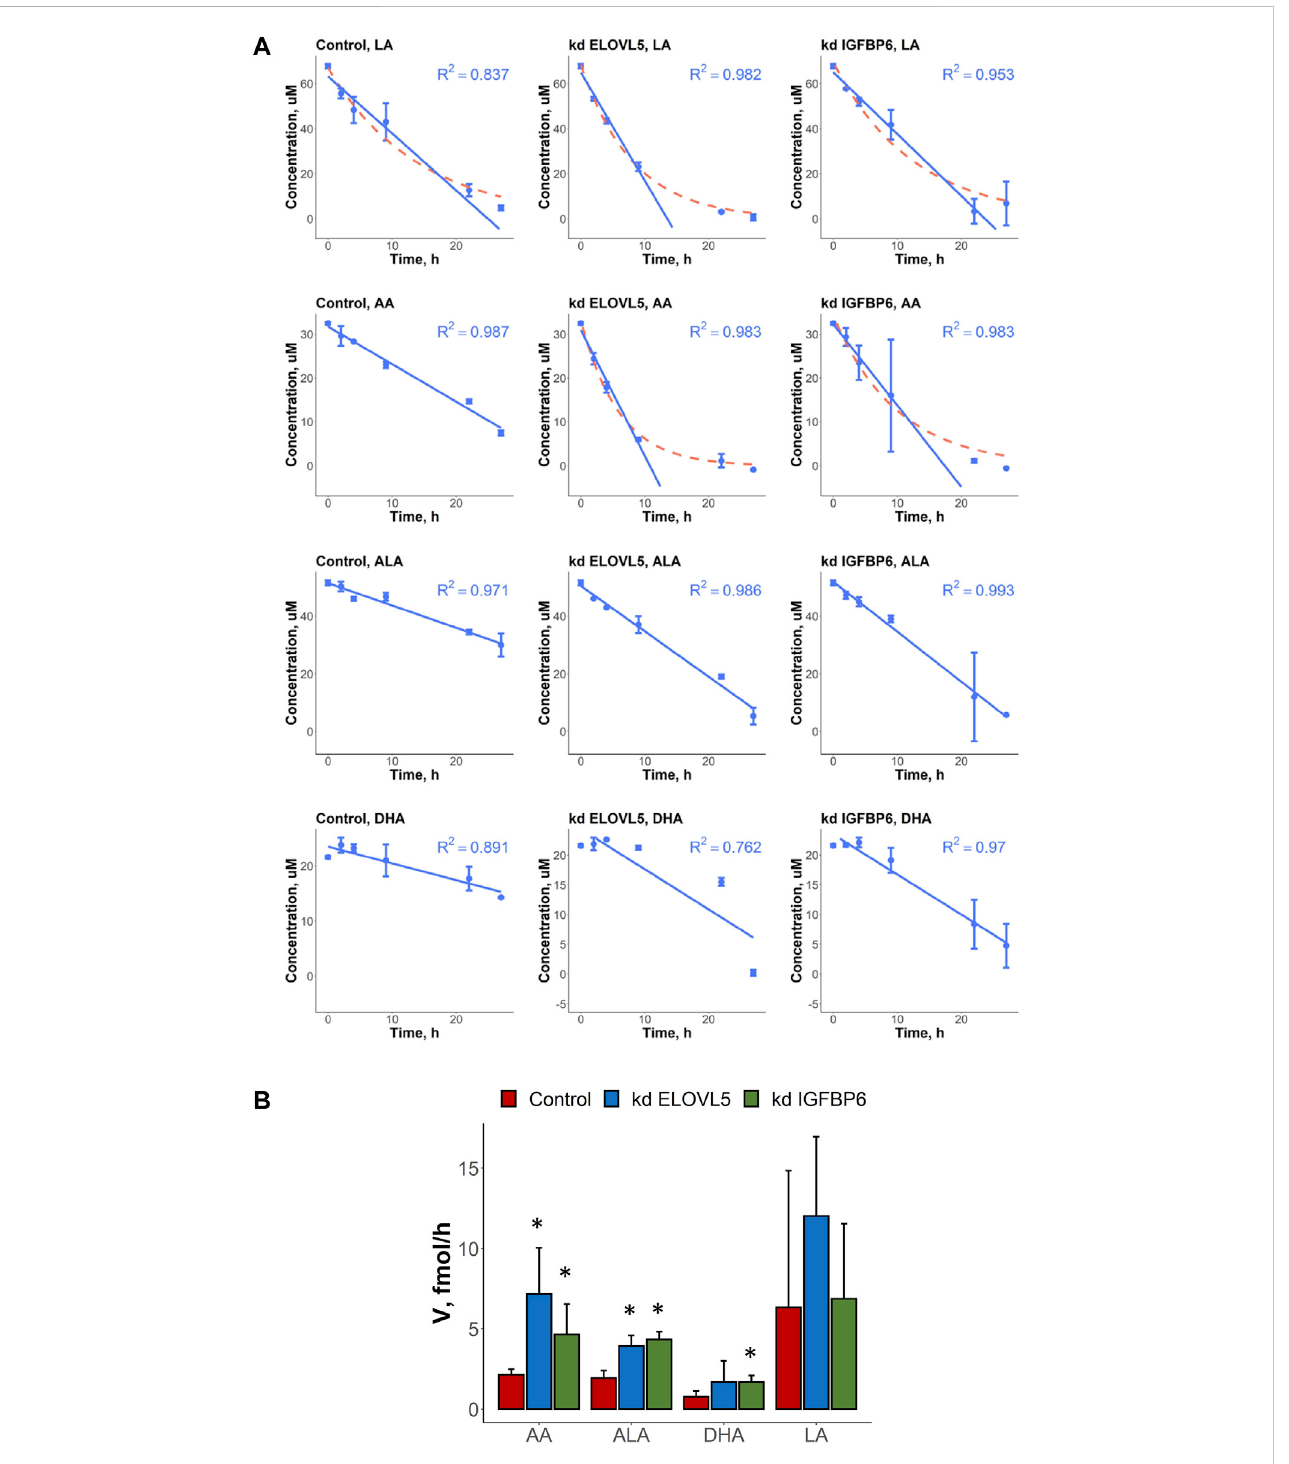
FIGURE 2 (A) KineticsofchangesintheconcentrationofvariousPUFAs(LA,AA,ALAandDHA)incellculturemedium inthepresenceofcontrolMDA-MB-231cells and the cells with knockdown of ELOVL5 and IGPBP6 genes. Error bars represent standard deviation (SD, n = 2). (B) Calculated uptake rates (per one cell) of various PUFAs(LA, AA, ALA and DHA) for control MDA-MB-231 cells andfor thecells with knockdown of ELOVL5 and IGPBP6 genes. Errorbars represent 95% con fi dence intervals. * — statistically signi fi cant difference versus control